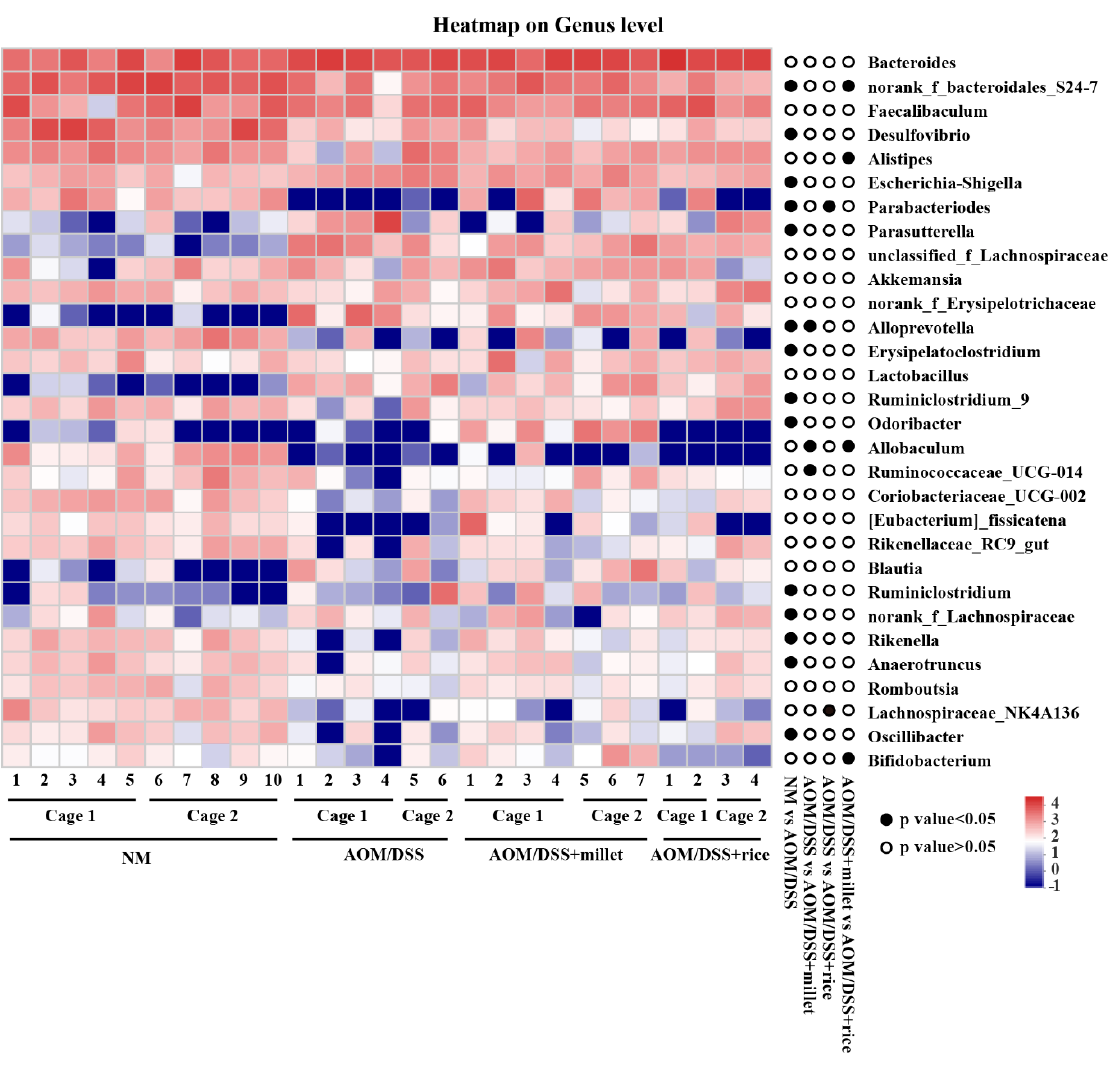
Figure 8. Heatmap analysis at genus level. * p < 0.05 by Kruskal–Wallis with Dunn’s test. n = 10, 6, 7, and 4 for the NM, AOM/DSS, AOM/DSS + millet, and AOM/DSS + rice groups, respectively.